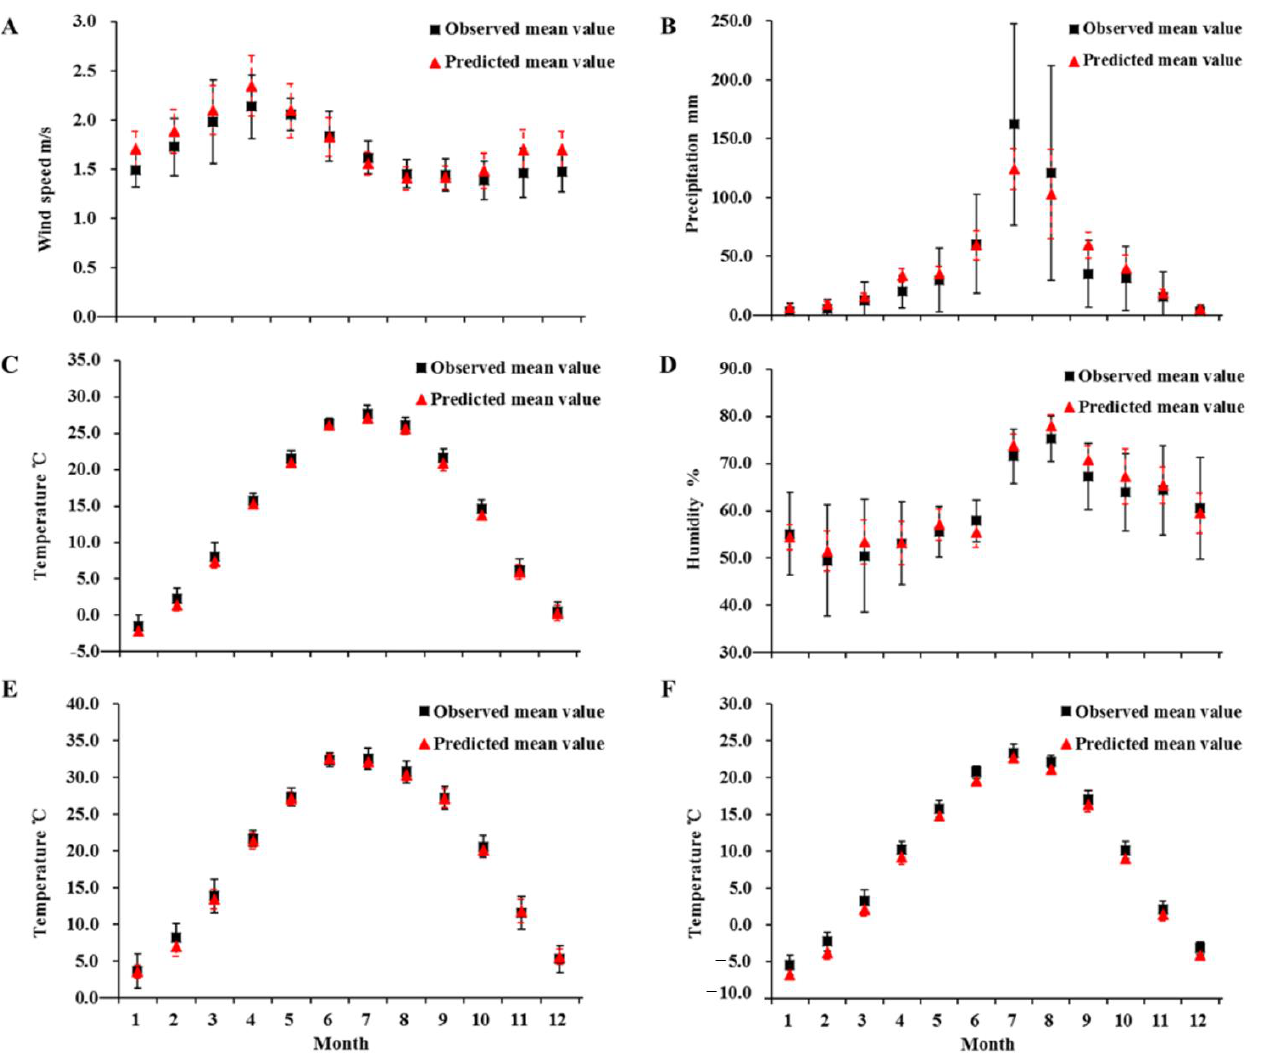
Figure 1. Comparison between the measured and simulated values in the piedmont plain area of Hebei Province during the verification period. Note: ( A ) The wind speed; ( B ) the precipitation; ( C ) the average temperature; ( D ) the humidity; ( E ) the maximum temperature; and ( F ) the minimum temperature. Table 3. Simulation results of scale reduction in the piedmont plain area in Hebei Province .